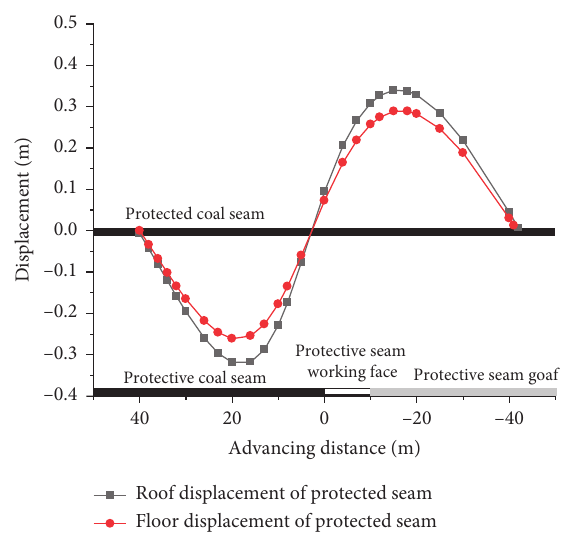
Figure 12: Curve of displacement change of the top and bottom plates of the protected layer.